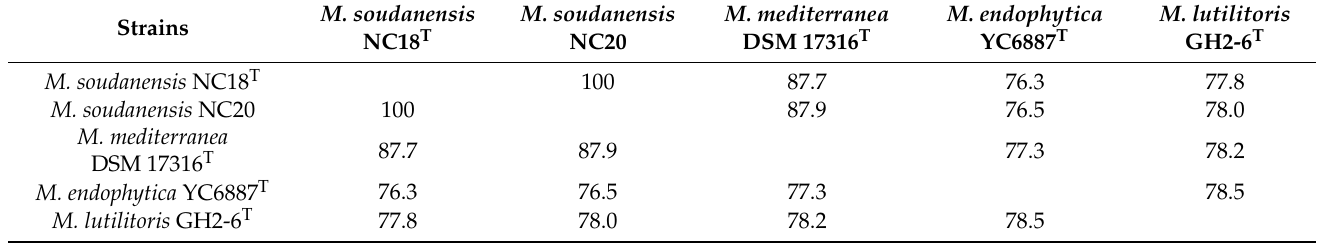
Table 5. AAI results of strains NC18 T and NC20 with related taxa within the genus Martelella . Strains